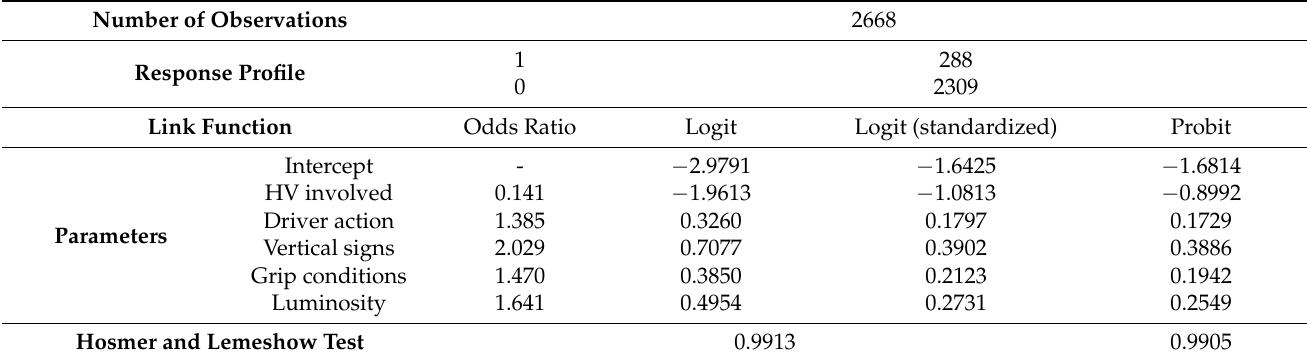
Table 5. Estimated coefficients and odds for elderly driver